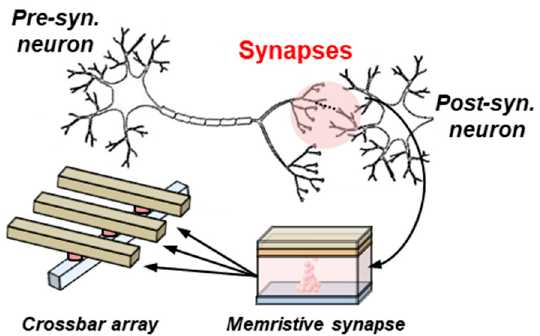
Figure 1. Electronic synapses can be implemented with memristive devices. The electronic neural network is implemented in a synaptic matrix layer.